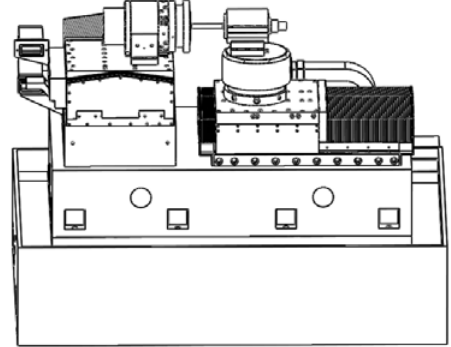
Figure 2. Grinder